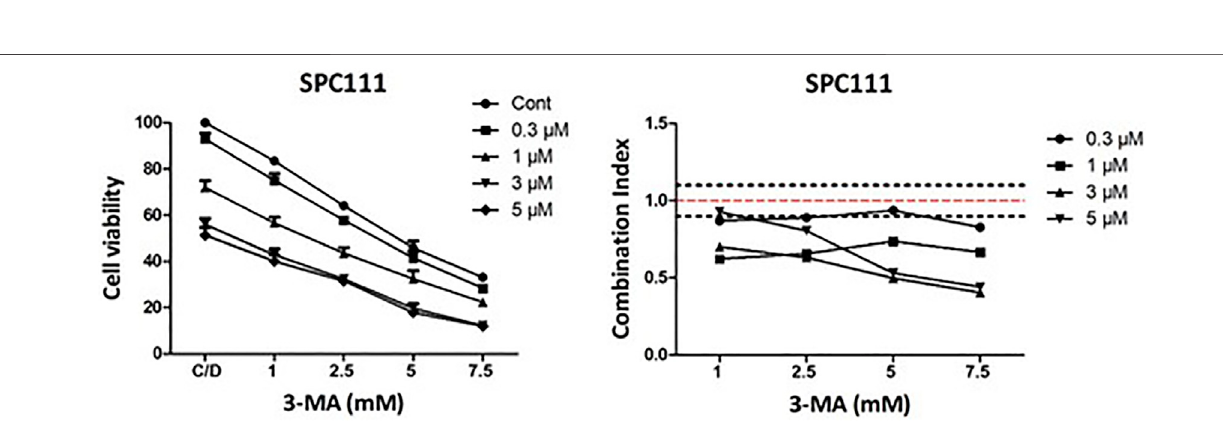
Frontiers in Cell and Developmental Biology |